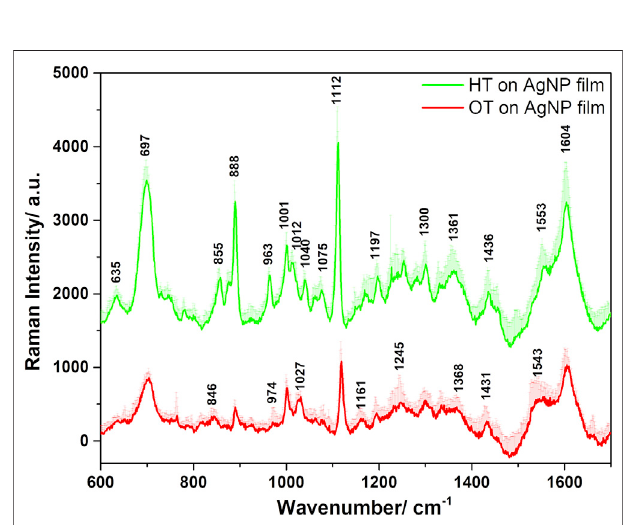
FIGURE 8 | Average SERS spectra of the HT- and OT-functionalized AgNP fi lms plotted together with their positive standard deviations, obtained under 633 nm